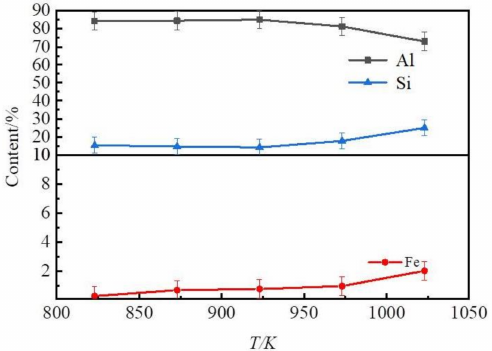
Figure 5. Effect of liquation temperature on composition of the Al–Si